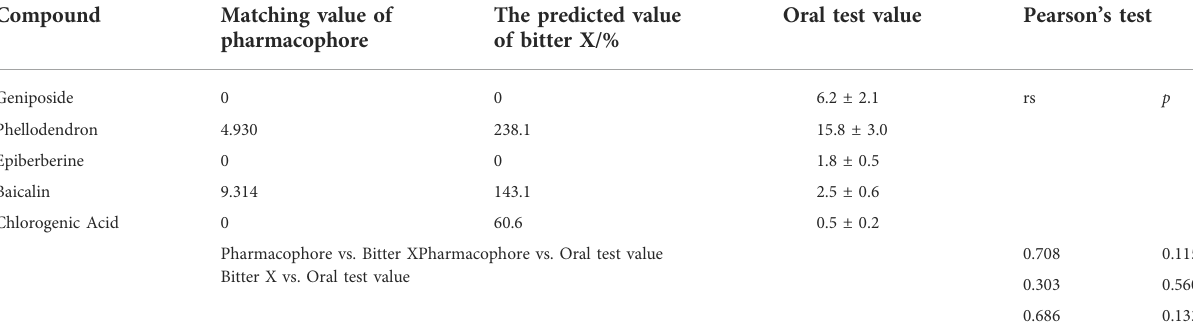
TABLE 4 Oral taste results (tasted bitter n = 15, ‾ x ± SD).